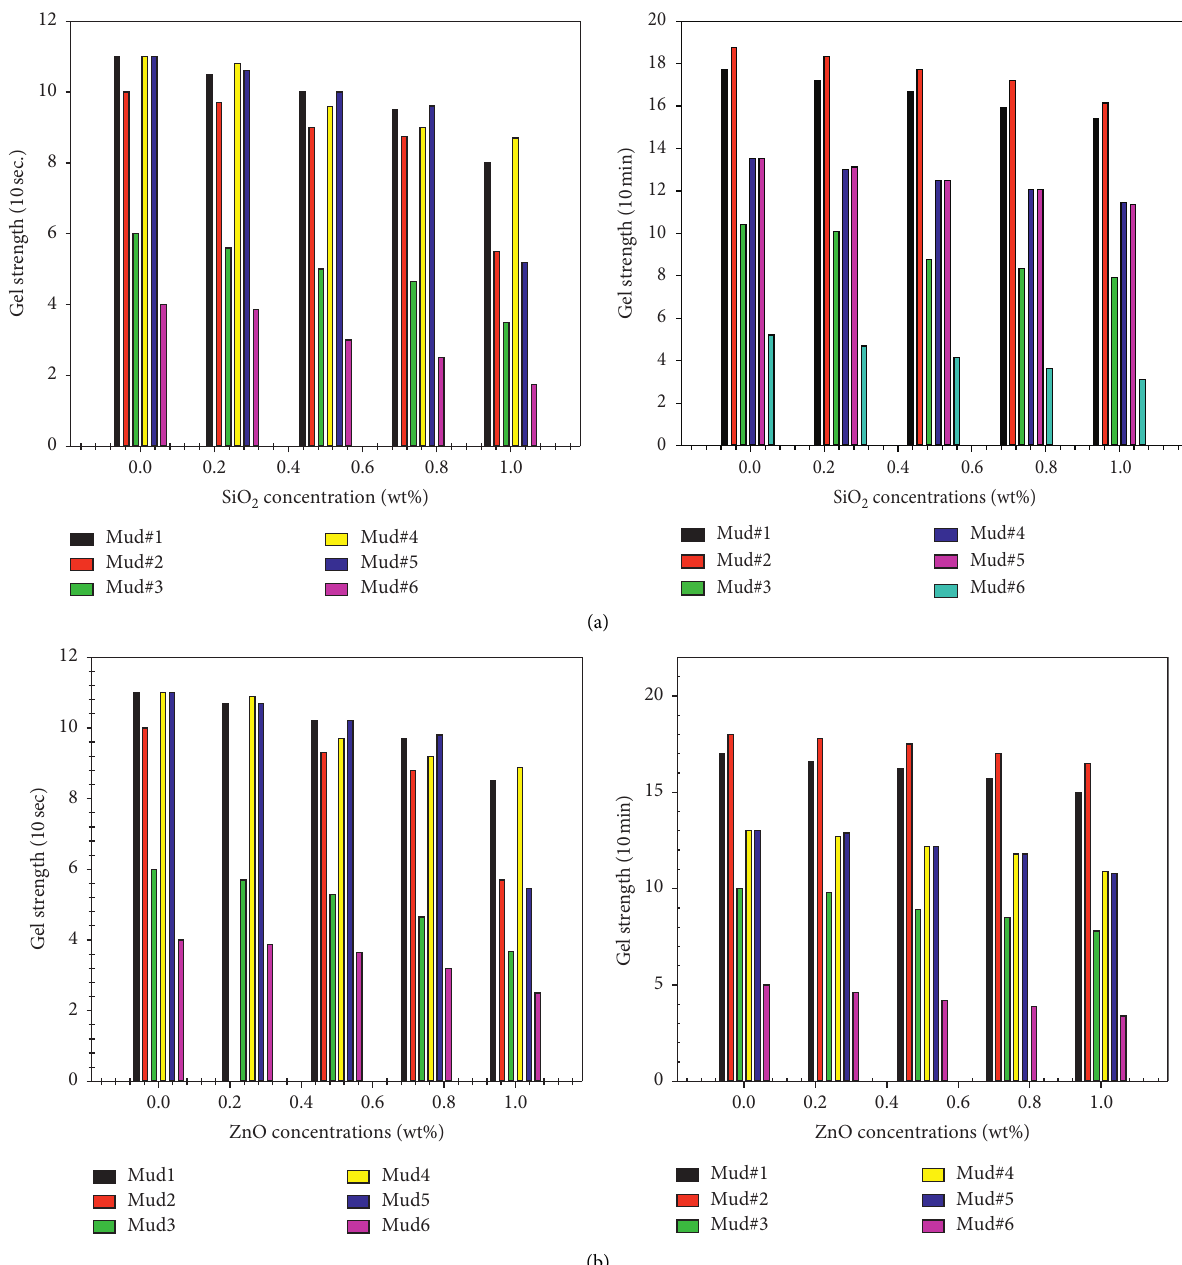
Figure 6: Comparison of 10min and 10 sec gel strengths of different WBM systems at different wt.% concentrations by (a) adding SiO and (b) adding ZnO